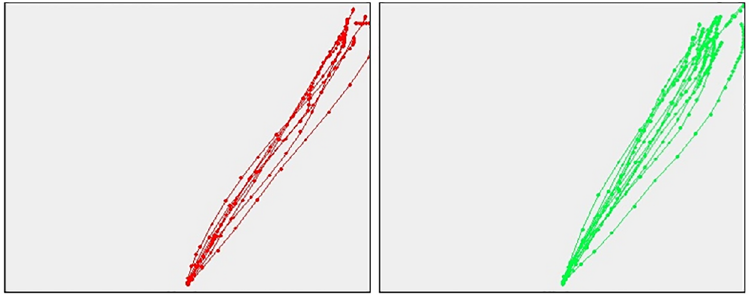
Fig 2. Prototypical trajectoryof a truth-teller. Responsesof a truth-teller (subject 3) to control (red) and unexpectedquestions(green). Trajectories refer to responses to single questions.